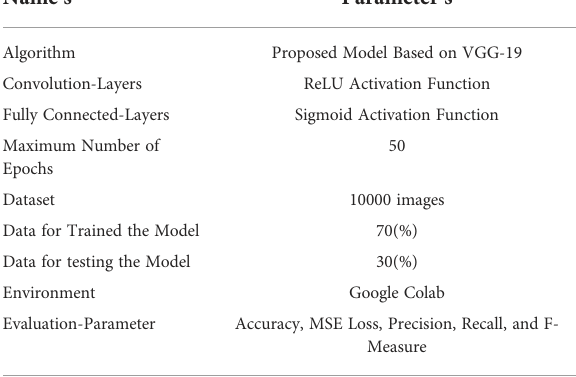
TABLE 4 Simulation parameters of LWNet